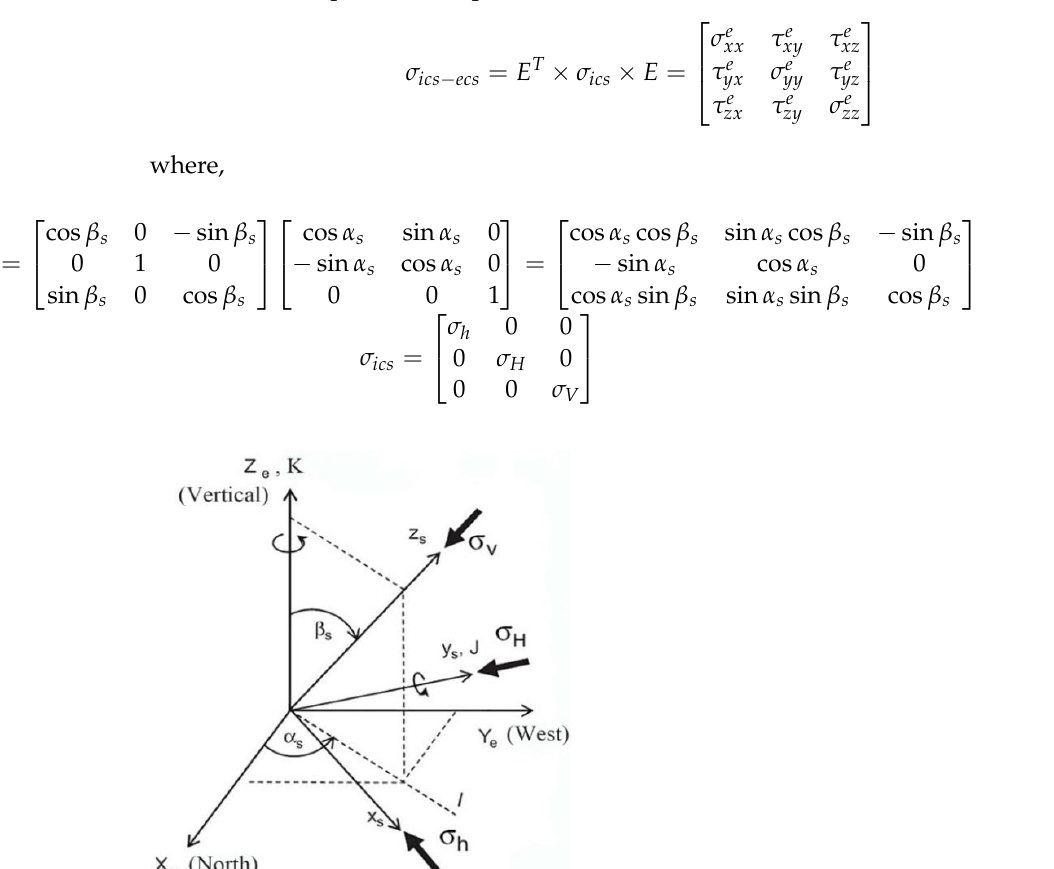
Figure 6. The conversion relationship between global coordinate system and in-situ stress coordi- nate system.